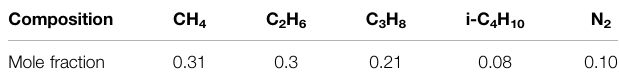
TABLE 2 | Molar composition of the freezing mixture.